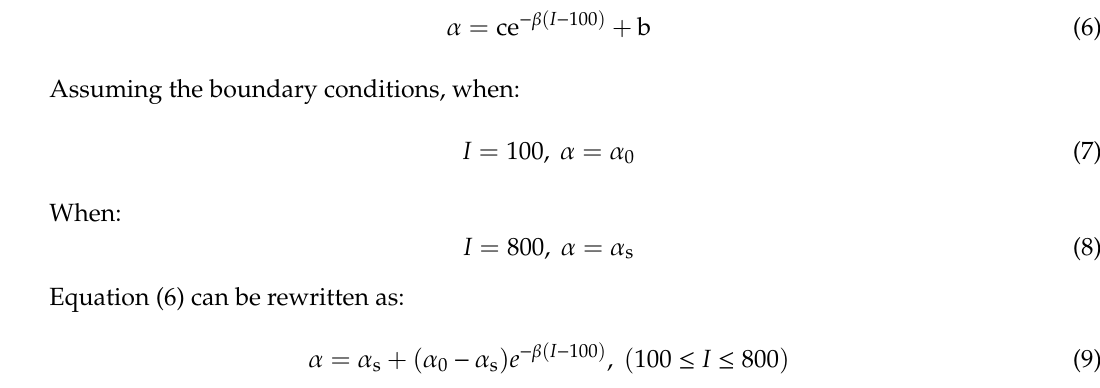
Figure 21. Variation of the average absorptivity for the testing rigs operated under the simulated radiation of 800 W/m 2 .